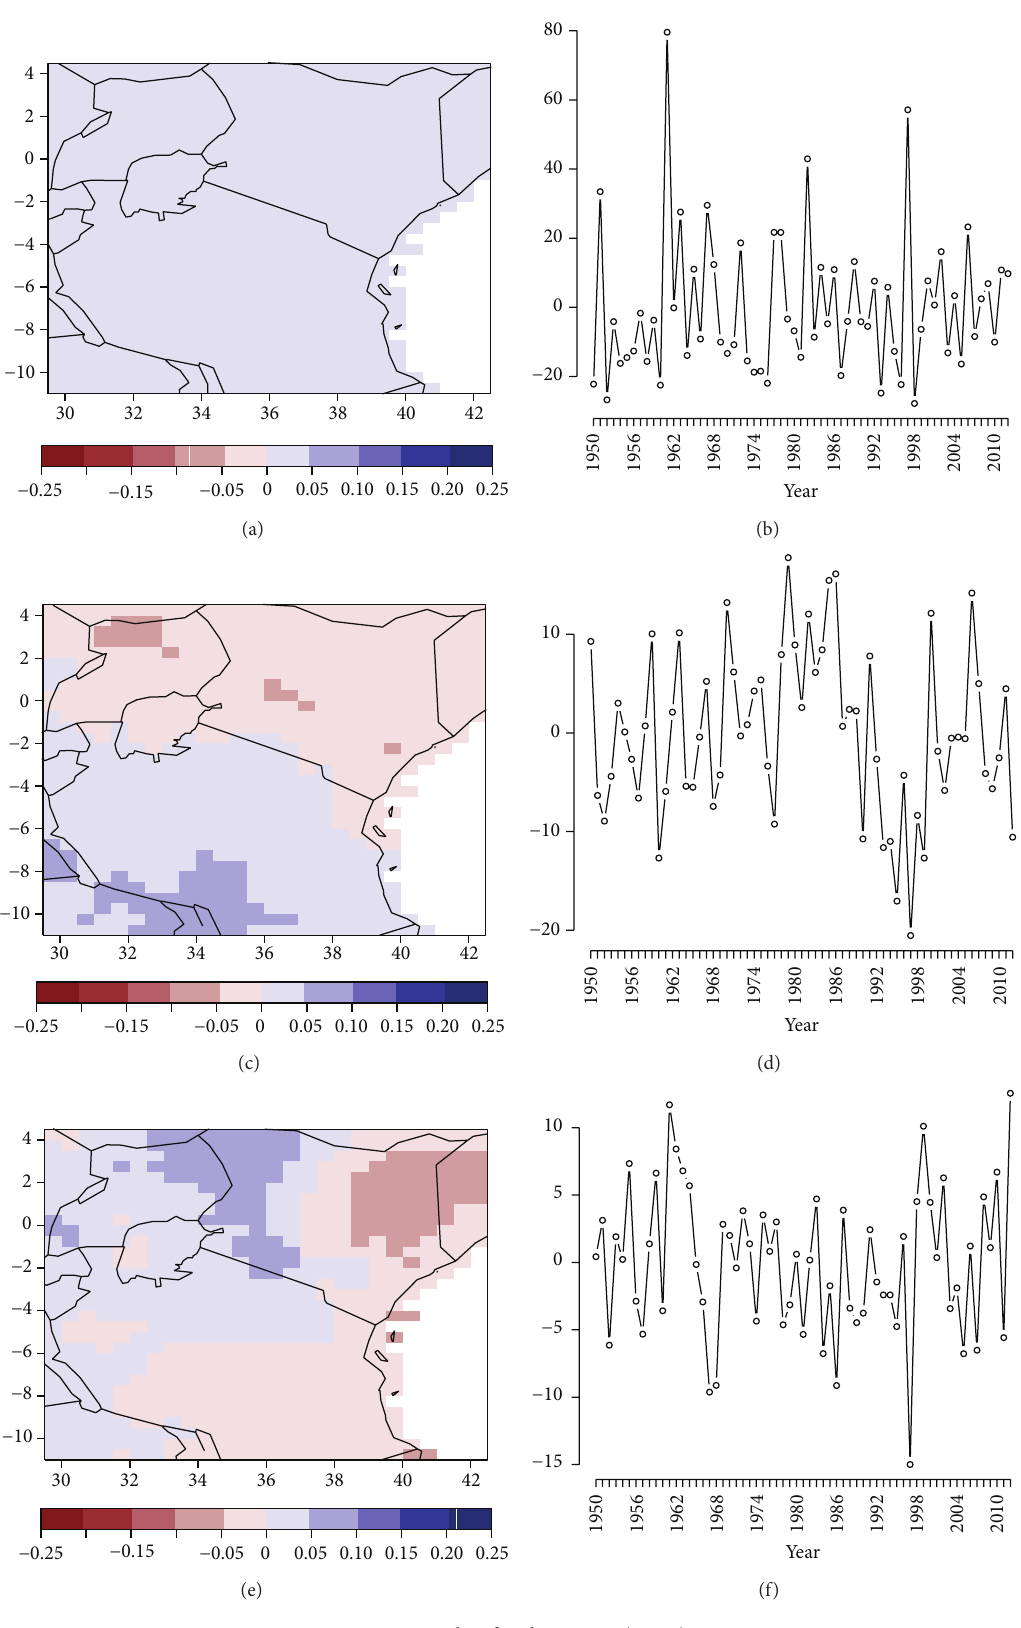
Figure 5: Same as Figure 3, but for short rains (OND)